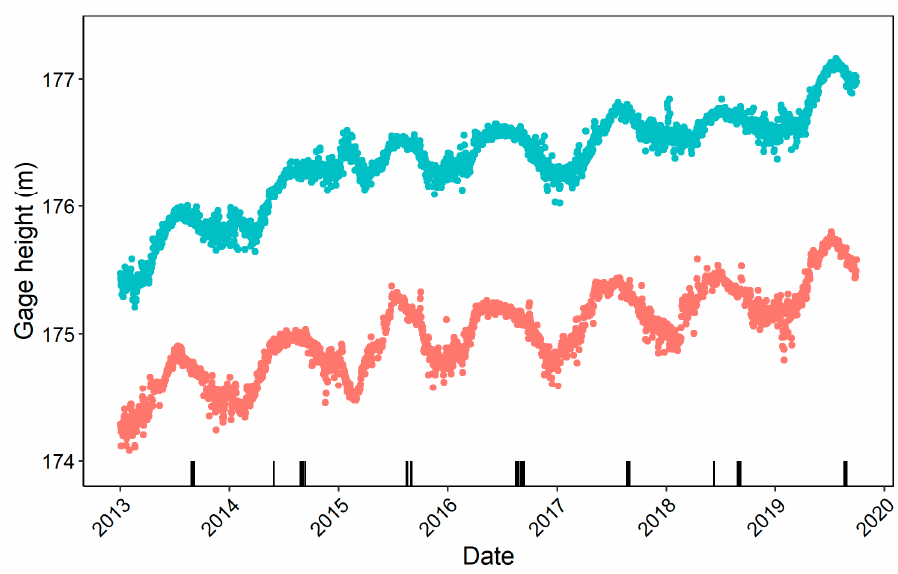
Figure 2. Water levels at the Detroit River (red circles; USGS—US Geological Survey stream gage 04165710, Fort Wayne, Michigan; https://waterdata.usgs.gov/ accessed on 6 June 2021) and St. Clair River (blue circles; USGS stream gage 04159130, Port Huron, Michigan). The rugs (black bars) denote timing of seine sampling events.